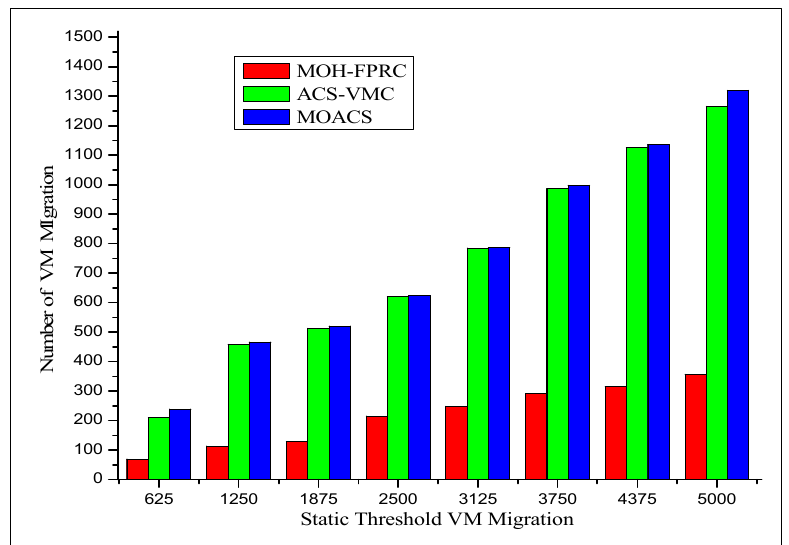
Figure 8. Comparison of algorithms using ST migration strategy.